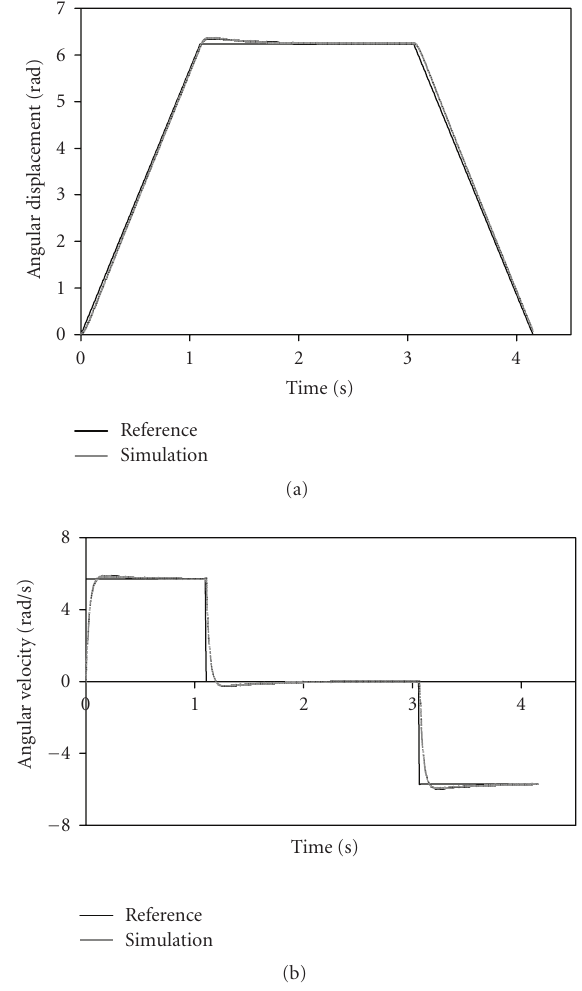
Figure 2: Simulation results for trapezoidal motion I.